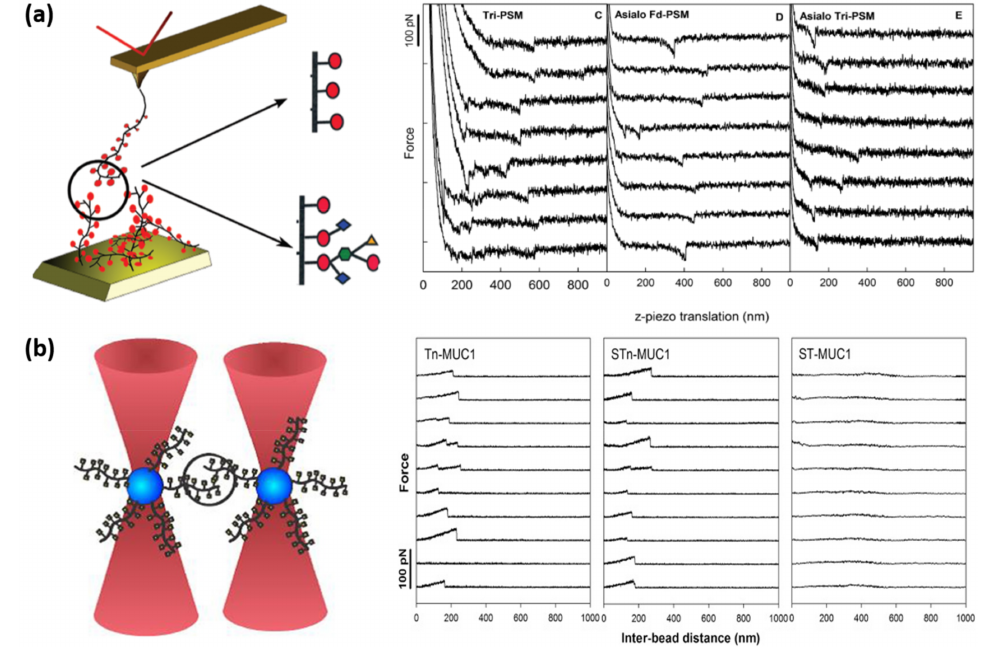
Figure 4. Glycan-glycan interactions probed by AFM and OT. ( a ) AFM schematic representation and force curves obtained when probing the self-interactions between AFM tips and mica surfaces functionalized with pig submaxillary mucin (PSM) harboring three different glycan decorations (Tri-PSM, Asialo Fd-PSM and Asialo Tri-PSM). Reprinted with permissions from [152]. ( b ) OT schematic representation and force curves obtained when probing the self-interactions between two polystyrene beads functionalized with mucins MUC1 harboring different glycan decorations (Tn-MUC1, STn-MUC1 and ST-MUC1). Reprinted with permissions from